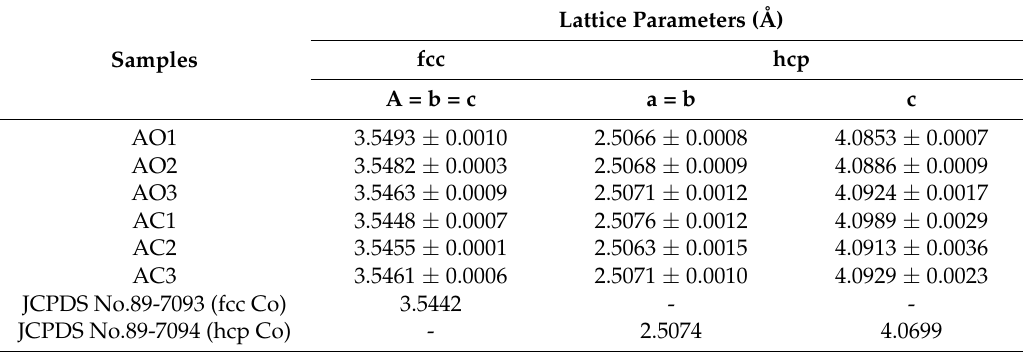
Table 2. Lattice parameters of alloy powders.